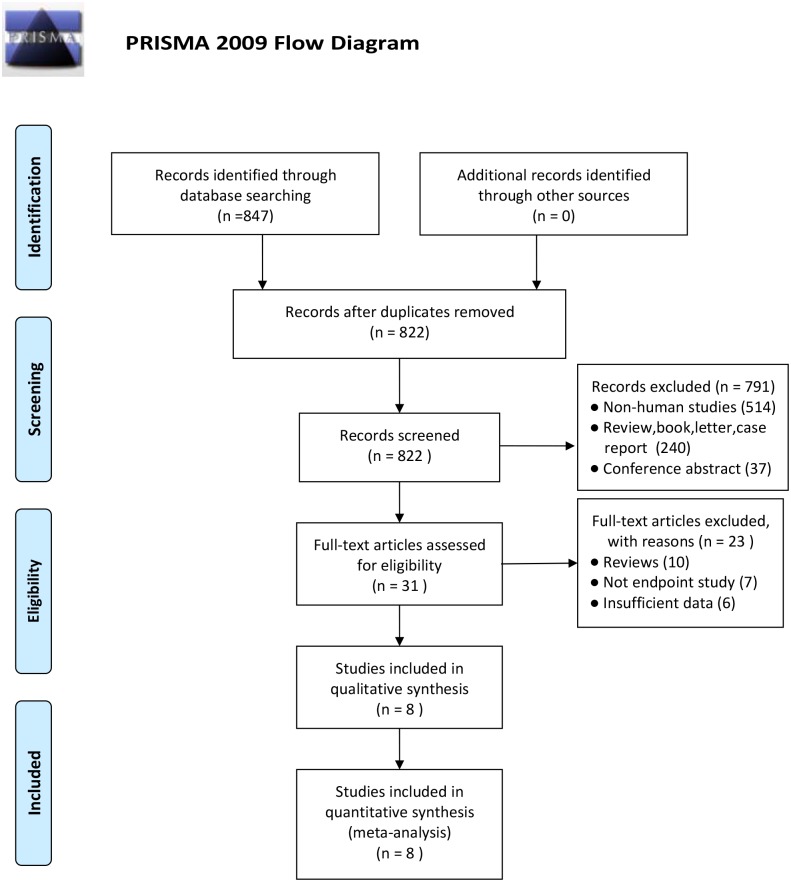
Flow diagram for identification of retrieved publications.From: Moher D, Liberati A, Tetzlaff j, Altman DG, The PRISMA Group (2009). Preferred Reporting items for Systematic Reviews and Meta-Analyses: The PRISMA Statement. PLOS Med 6(7):e1000097. doi: 10.1371/journal.pmed1000097 For more information, visit www.prisma-statement.org.